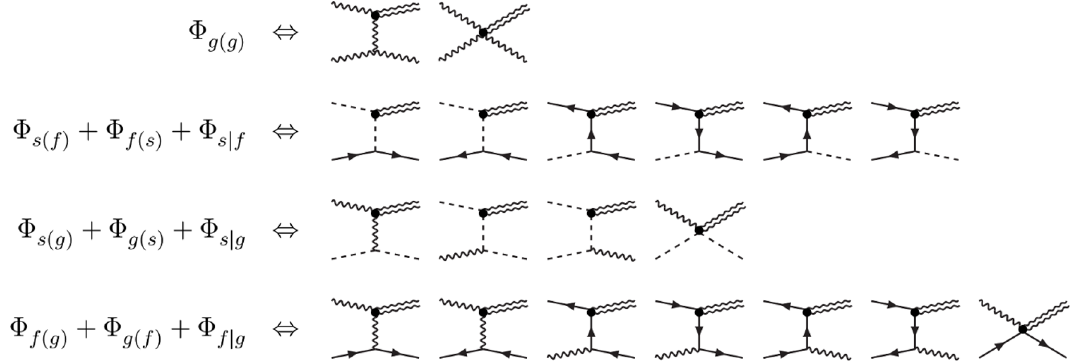
Figure 2 . t -channel 2 $ 2 scatterings contributing to gravitational wave production (further processes are obtained with u and s -channel re(cid:13)ections). The notation is as in (cid:12)gure 1, with the double line indicating a graviton. Up to numerical prefactors, the amplitudes squared originating from these processes, after summing over the physical polarization states of the gravitons and Standard Model particles, correspond to the cuts shown in eqs. (2.36){(2.38) (cf. section 2.4). At the light cone, there is a further identity that has not been employed yet and that permits for a remarkable simpli(cid:12)cation of eqs. (2.32){(2.34). Noting that for